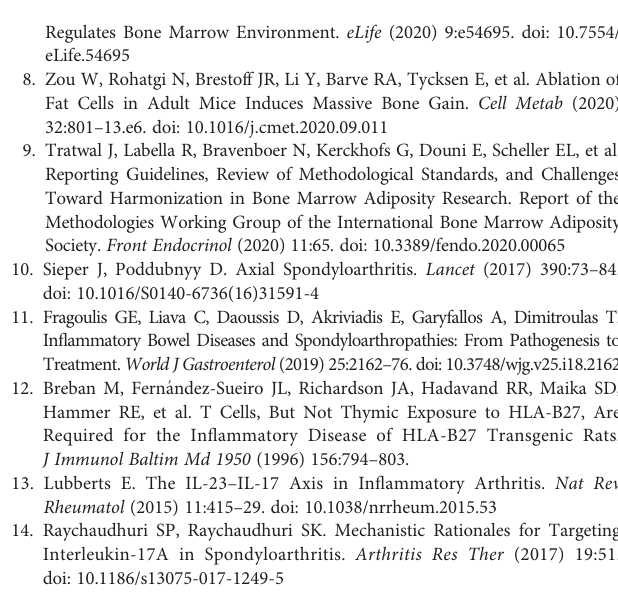
Supplementary Figure 1 | Effect of chronic in fl ammation on blood cells in the bone marrow of B27 rats. Percentage of neutrophil subpopulations (A) , other leucocyte populations (B) , and erythroblast populations (C) in the bone marrow of NTG and B27 rats (n=6-8 per group). Data are presented as mean ± SD. *p ≤ 0.05, **p ≤ 0.01, and ***p ≤ 0.001 NTG vs. B27 via unpaired Student´s